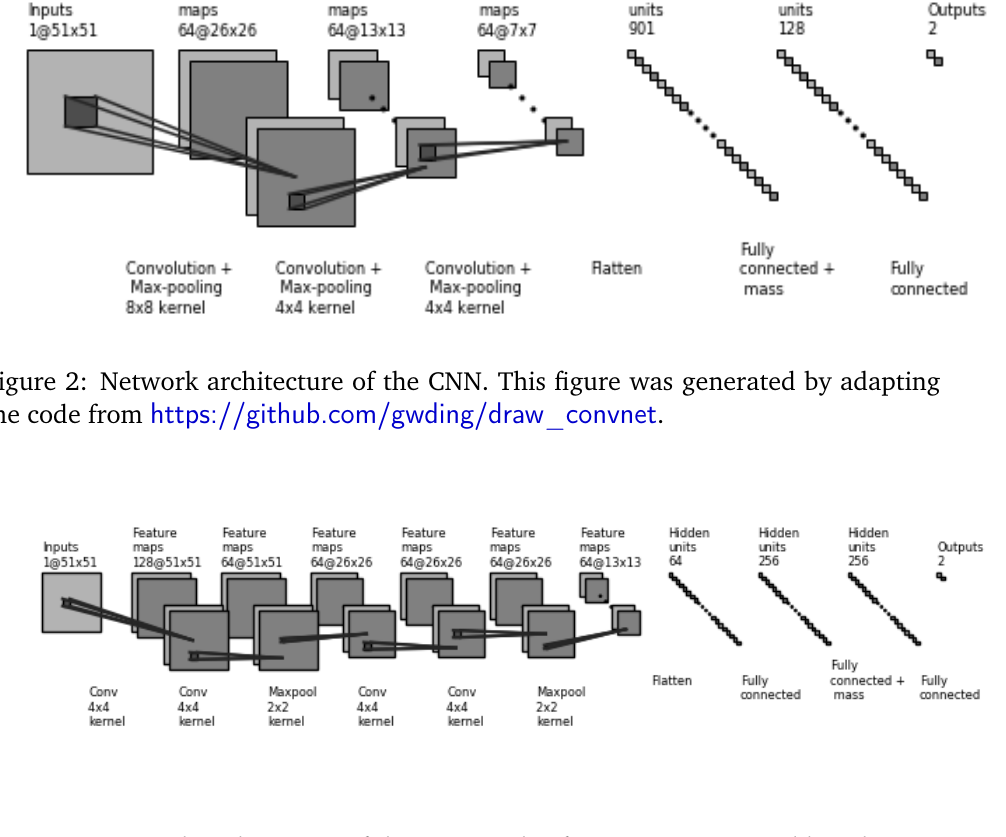
Figure 3: Network architecture of the CNN1. This figure was generated by adapting the code from https://github.com/gwding/draw_convnet